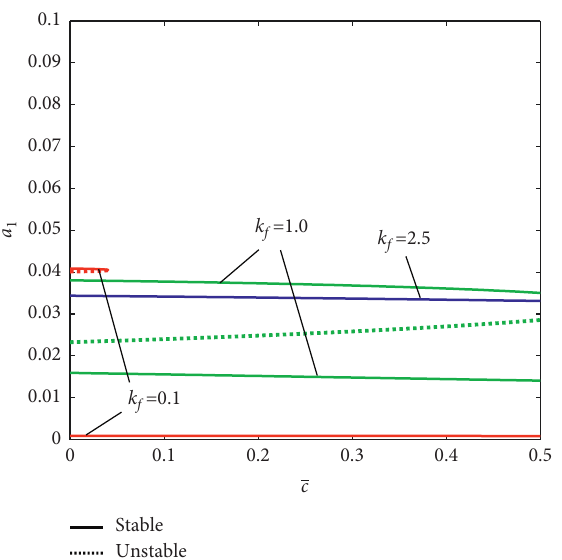
Figure 14: Amplitude versus damping coefficient with different rotating speed (L/d � 10, σ � 2, case